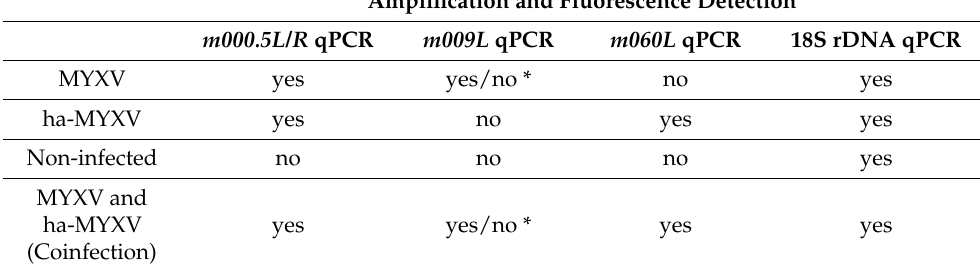
Table 1. Expected results for the different targets in the mPCR. * the m009L system may lack the detection of some classical MYXV strains (see Table